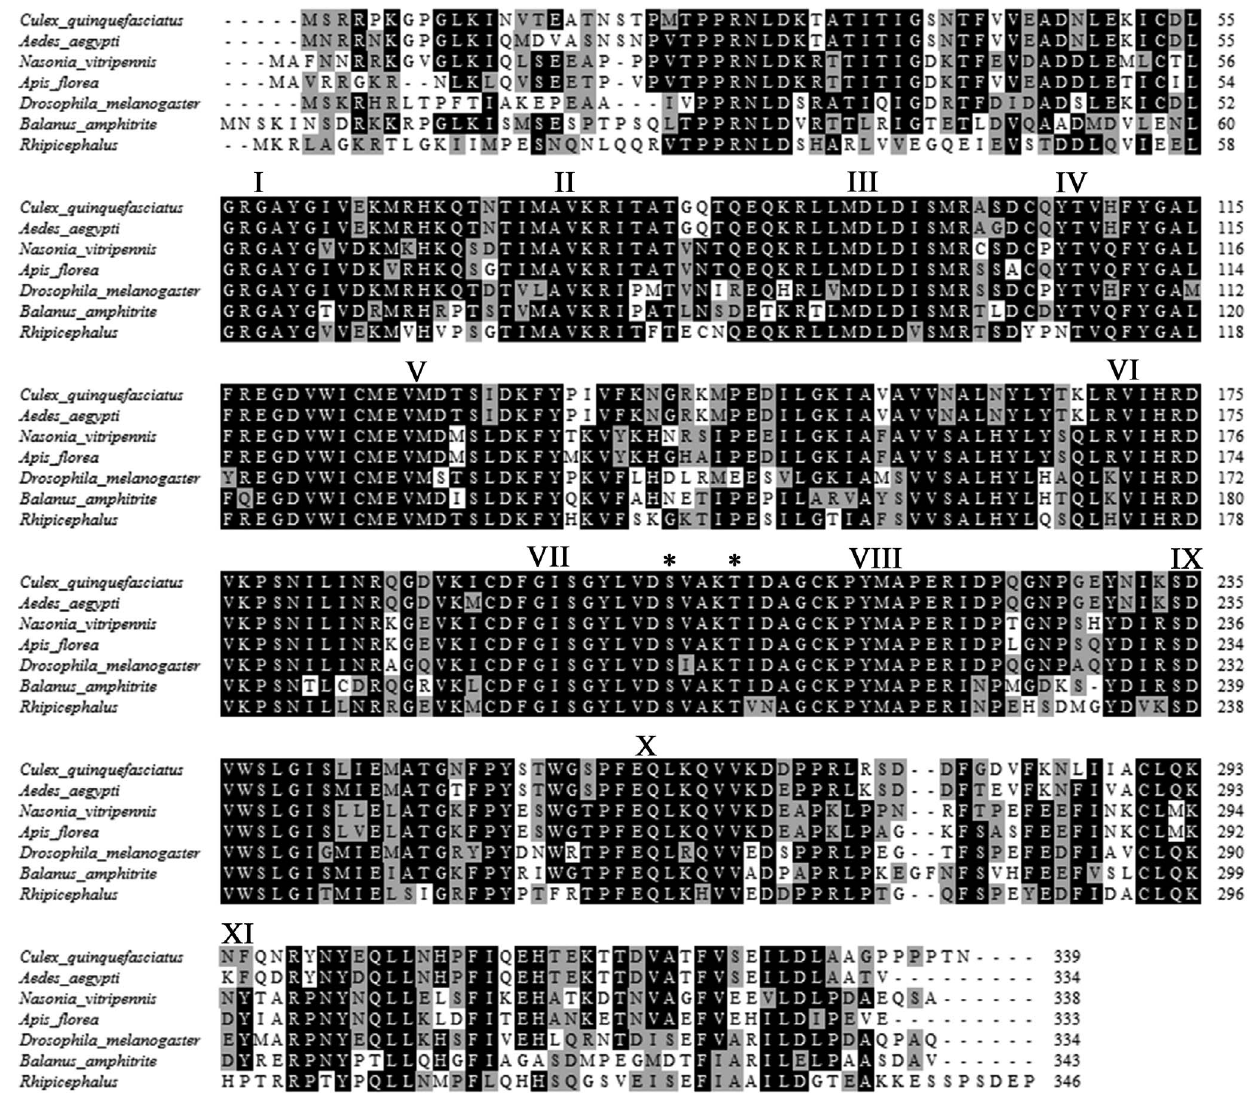
Figure 1. Alignment of MKK3 sequences from different species. Amphibalanus amphitrite MKK3 was aligned with those from Culex quinquefasciatus (XP001844745.1), Aedes aegypti (AAQ68075.1), Nasonia vitripennis (XP001604546.1), Apis florea (XP003689651.1), Drosophila melanogaster (AAF48223.1) and Rhipicephalus pulchellus (JAA59480.1). The subdomains I-XI were defined. The conserved dual phosphorylation sites were labeled with